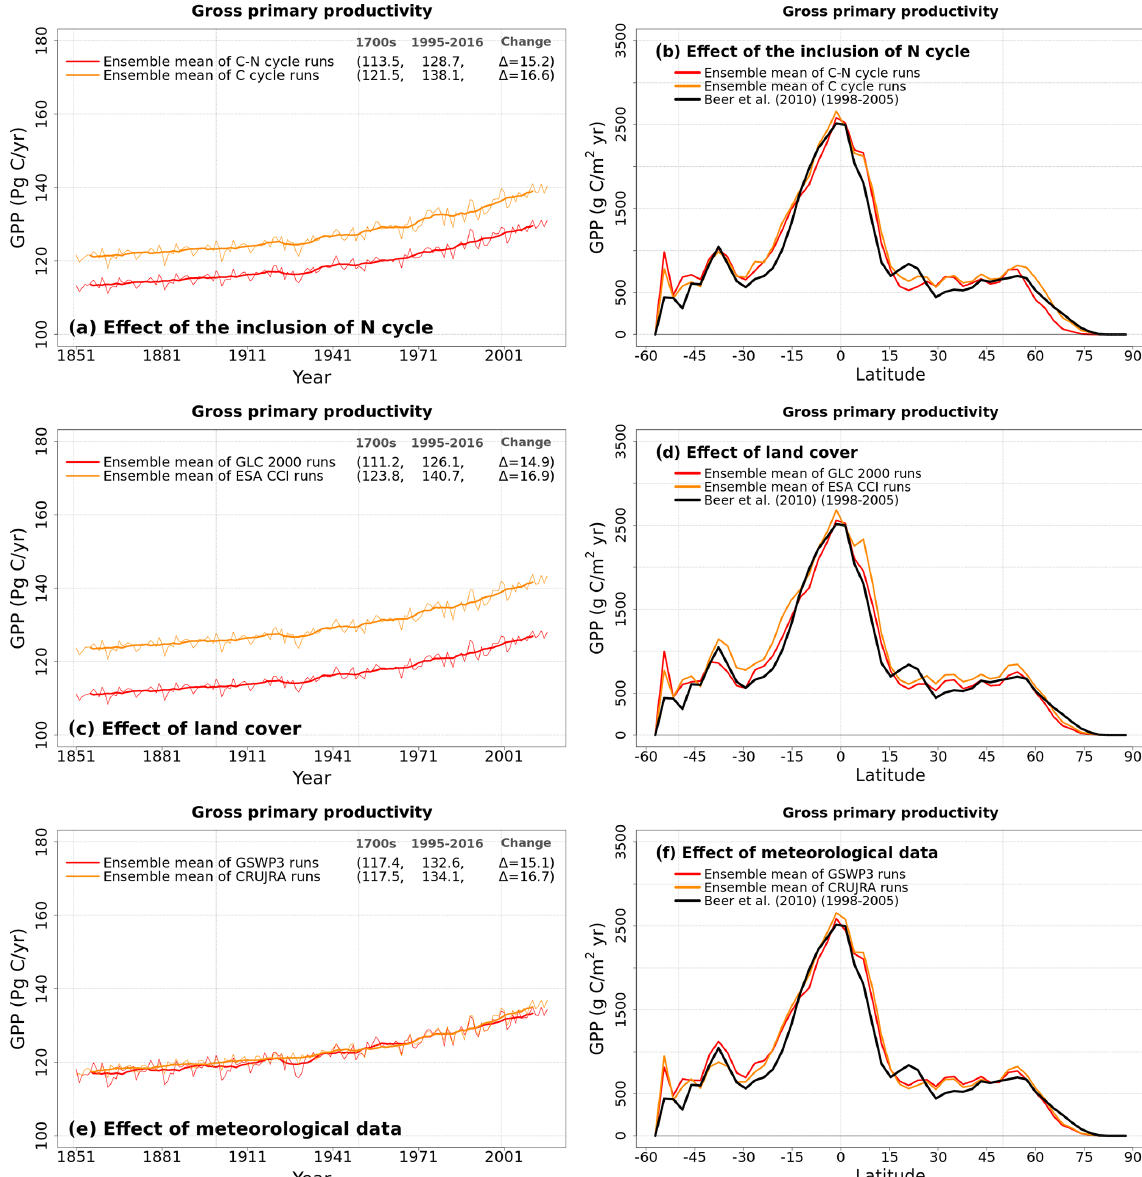
Figure 7. Time series of annual global gross primary productivity (over all land area excluding Greenland and Antarctica) (a, c, e) and zonally averaged values of gross primary productivity over land (b, d, f) averaged, for the period 1997–2016, over the four ensemble members that are driven with and without an interactive N cycle (a, b) , that are driven with the GLC 2000 and ESA CCI based land cover representations (c, d) , and that are driven with GSWP3 and CRU-JRA meteorological data (e, f) . The thin lines for the time series show the individual years, and the thick lines show their 11-year moving average. Model values averaged over the pre-industrial (1851–1860) and present-day (1997–2016) time periods, and their difference, are also shown in a, c, e